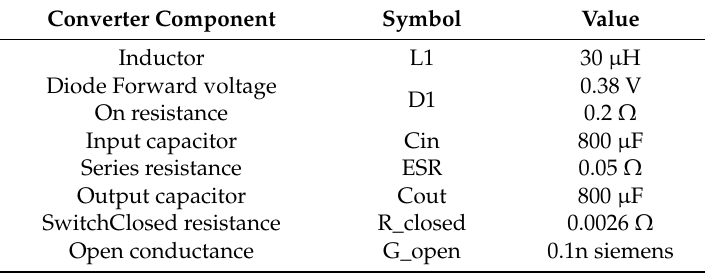
Table 1. List of electronic components for the boost converter design.